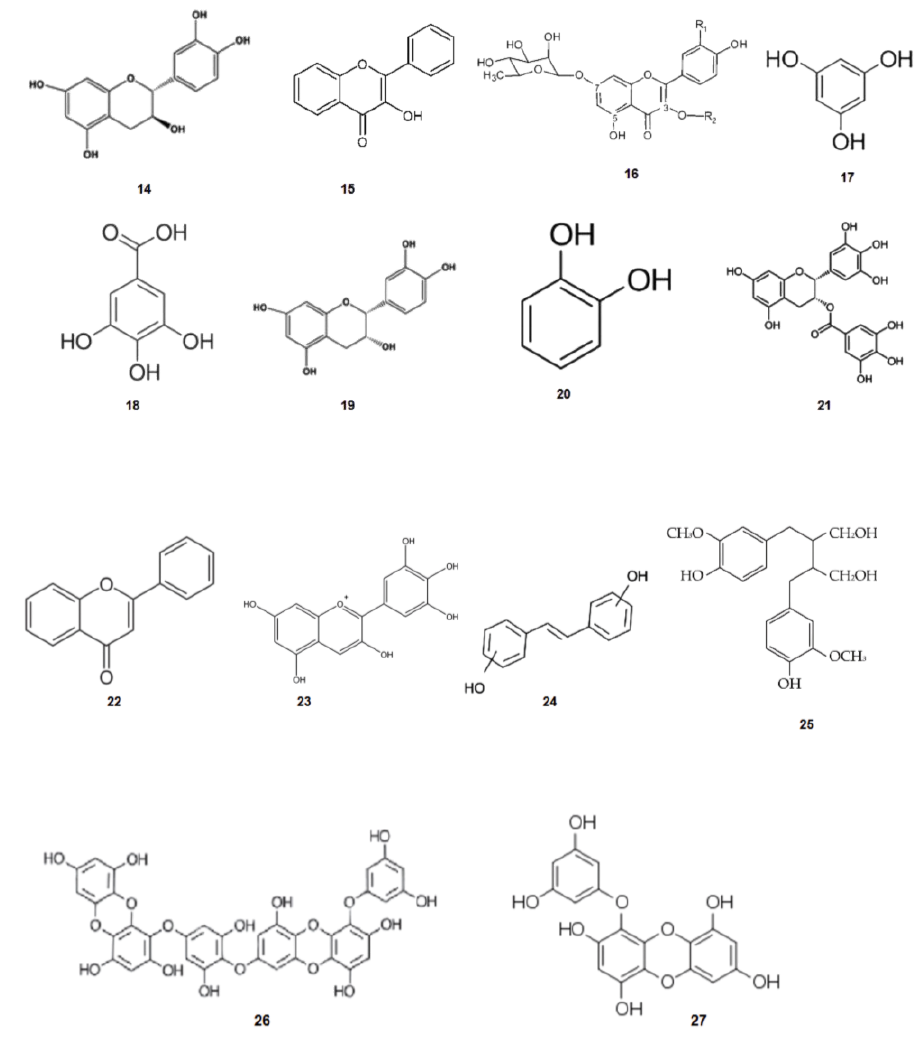
Figure 4. Phenolics from macroalgae.